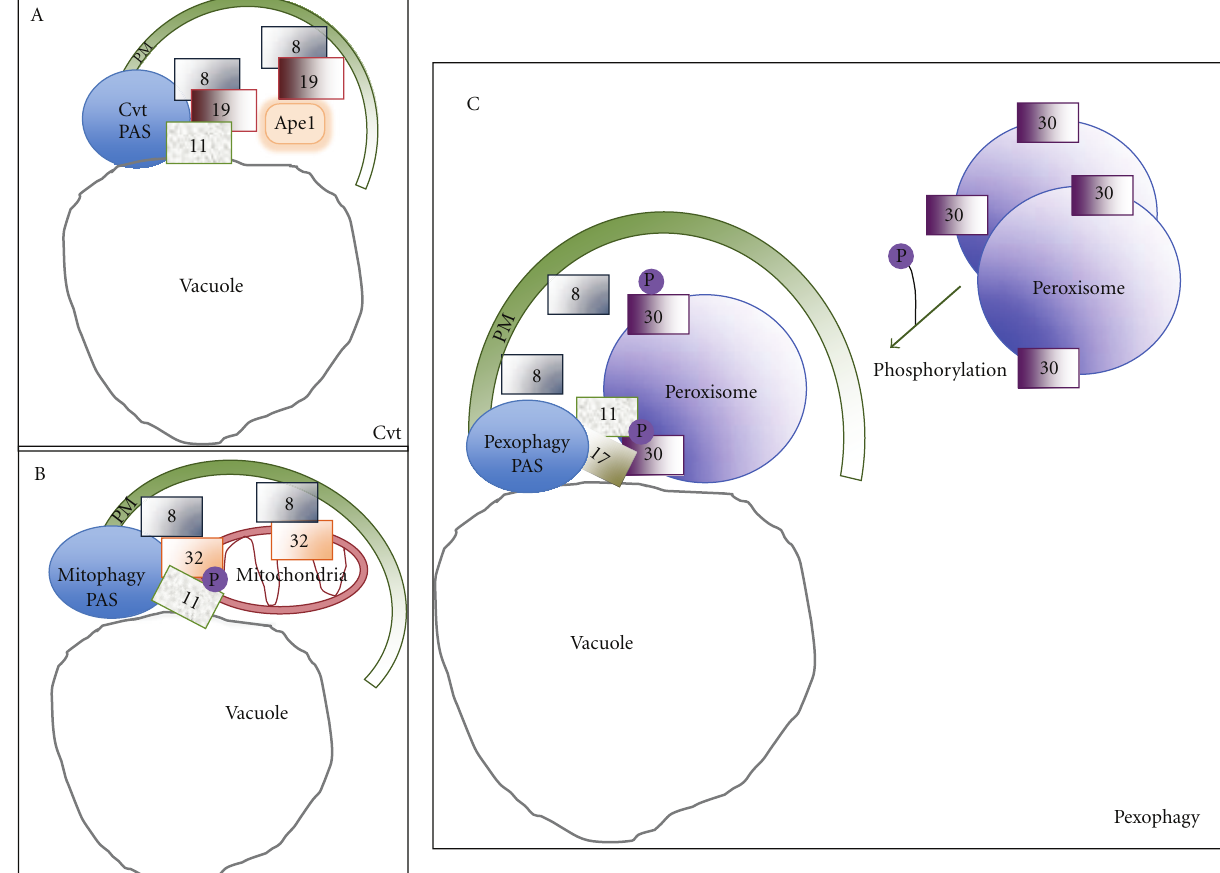
Figure 3: Similarities and di ff erences between selective autophagy pathways. Various selective autophagy pathways share similar molecular mechanisms. They require a receptor that interacts with the cargo, recruits a sca ff old protein (Atg11) that organizes the core autophagic machinery at the PAS, and mediates recruitment of Atg8, which initiates phagophore elongation from the PAS. In the Cvt pathway (a) Atg19 and Atg34 are the receptors for the cargo proteins aminopeptidase I (Ape1) and alpha-mannosidase, respectively. These receptors bind to Atg11 at the Cvt-specific PAS to initiate membrane expansion of the phagophore. (b) The mitophagy-specific phagophore membrane expansion from the PAS is initiated by Atg32, a mitochondrial outer membrane protein. Atg32 also interacts with Atg11 and Atg8. (c) The pexophagy receptor, Atg30, is localized at the peroxisome membrane, via interaction with the PMPs, Pex3, and Pex14. It is phosphorylated upon induction of pexophagy resulting in interaction of Atg30 with core autophagic machinery components, Atg11 and Atg17. In the case of pexophagy, the direct Atg8 interaction partner is still